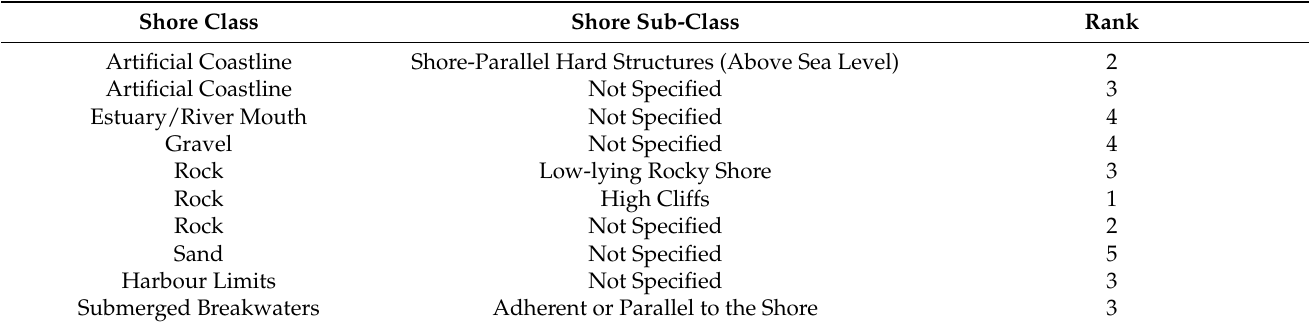
Table A1. Ranks assigned to the geomorphology data input used for the case study.